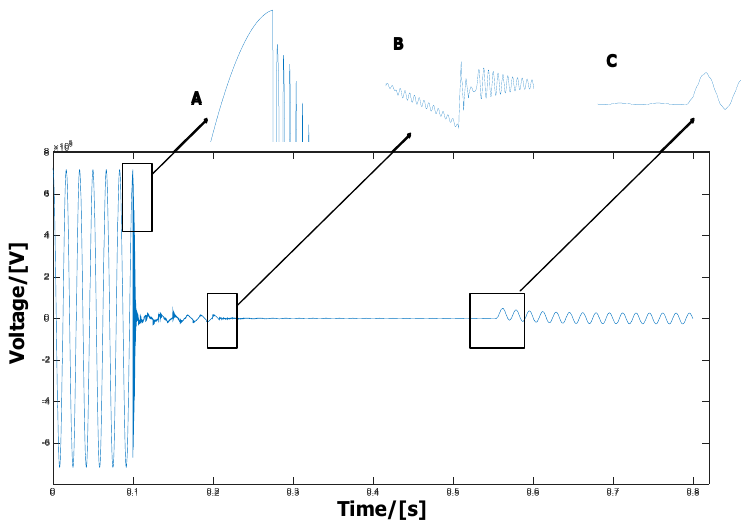
Figure 4. Voltage signal due to the temporary fault.